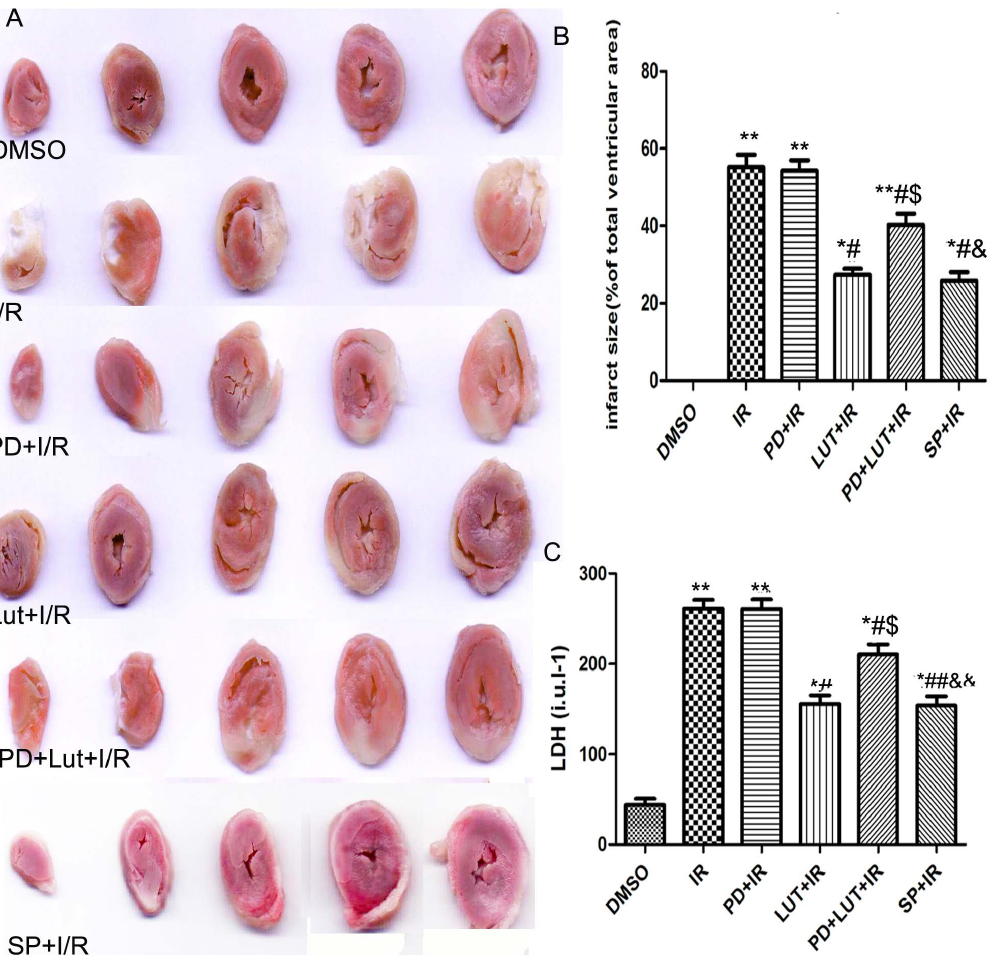
Figure 2. Infarct size and LDH release quantity of each group. Effects of luteolin and SP600125 on infarct size (A, B) and release of LDH (C) in isolated I/R hearts. The results are expressed as the mean 6 SEM, n=6. *P , 0.05, **P , 0.01 versus DMSO; # P , 0.05 versus I/R; $ P , 0.05, versus I/R + Lut (40 m M), &&P , 0.01, &P , 0.05 versus I/R + Lut(40 m mol/L) + PD (20 m mol/L).